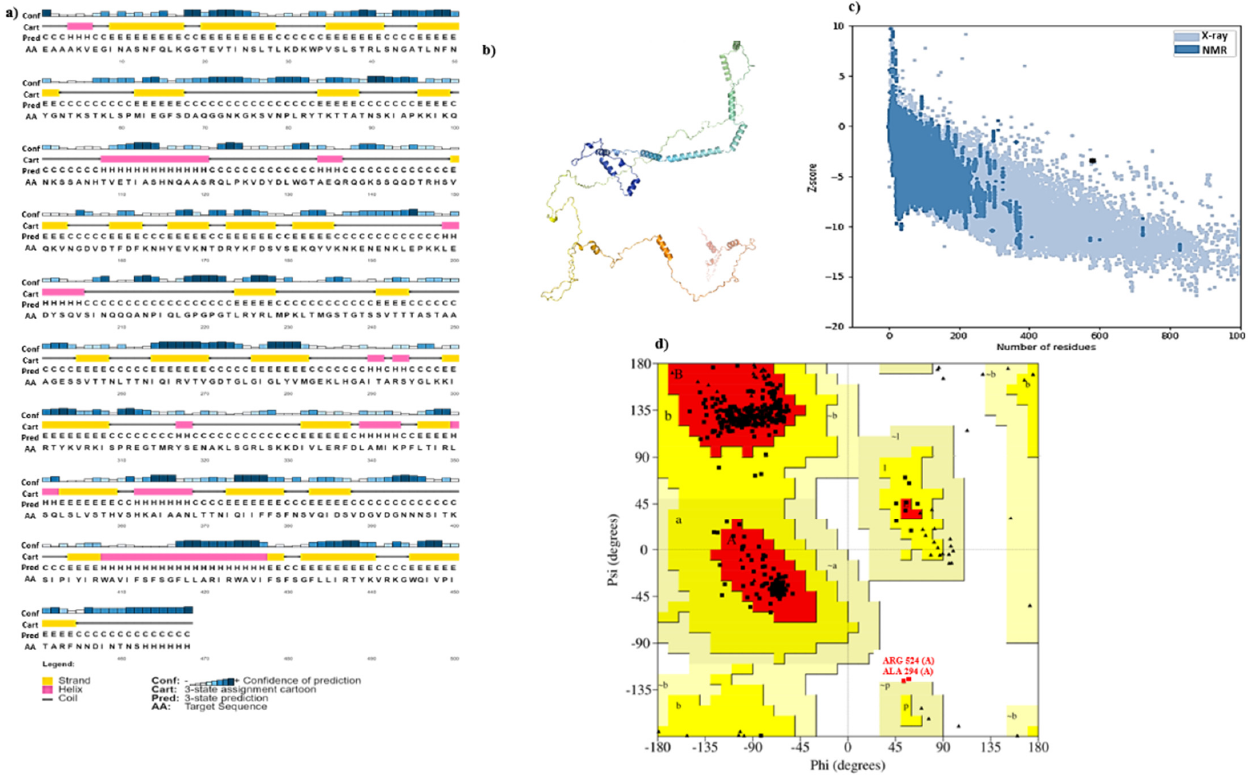
Figure 3. Structure prediction of the vaccine; ( a ) PSI-PRED predicted the 2D structure of the vaccine; ( b ) 3D structure predicted by Alpha fold Colab; ( c ) Z graph generated from ProSA web server; ( d ) Ramachandran’s plot describes the validity of vaccines through PROCHECK. The letters A and a represent right-handed alpha-helices (with A representing the region that has the most probability of being an alpha-helix and, a representing region with lesser probability and ~a with the least probability. The same goes for B, where B represents the region for B-sheets. L stands for left-handed alpha-helices with the probability decreasing from L to l. lastly ‘P’ represents the outlier region.